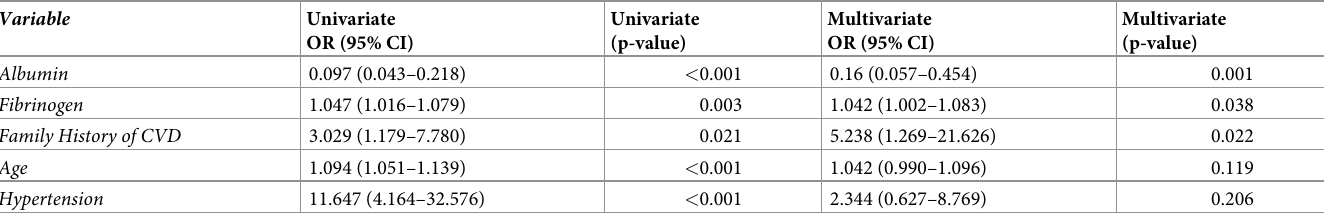
Table 2. Univariate and multivariate logistic regression analyses of risk factors of ACS.